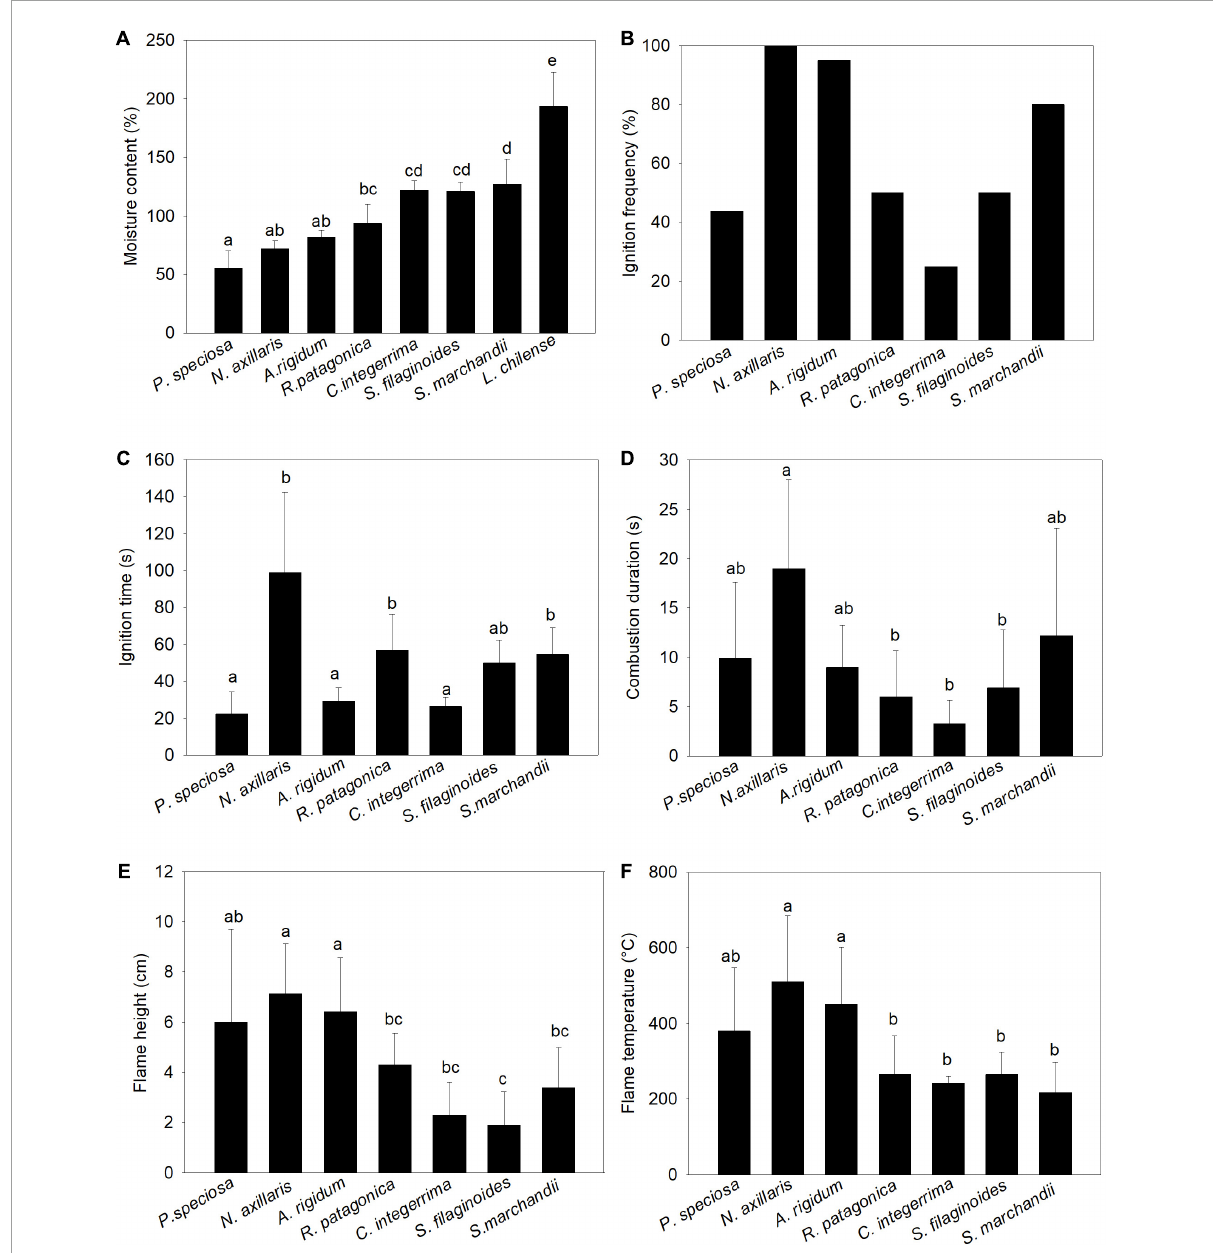
FIGURE4 Mean ± (SD) of flammability variables (at leaf-level) of the dominant species present in the vegetation units. (A) Moisture content (%), (B) ignition frequency, (C) ignition time, (D) combustion duration (s), (E) flame height (cm), and (F) flame temperature ( ◦ C). Different letters indicate significant differences among species ( P <